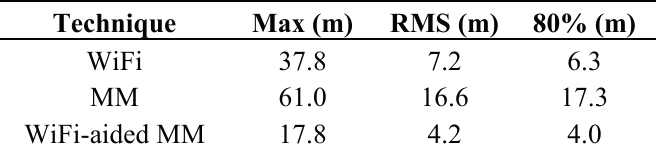
Table 2. Statistical values of navigation errors at